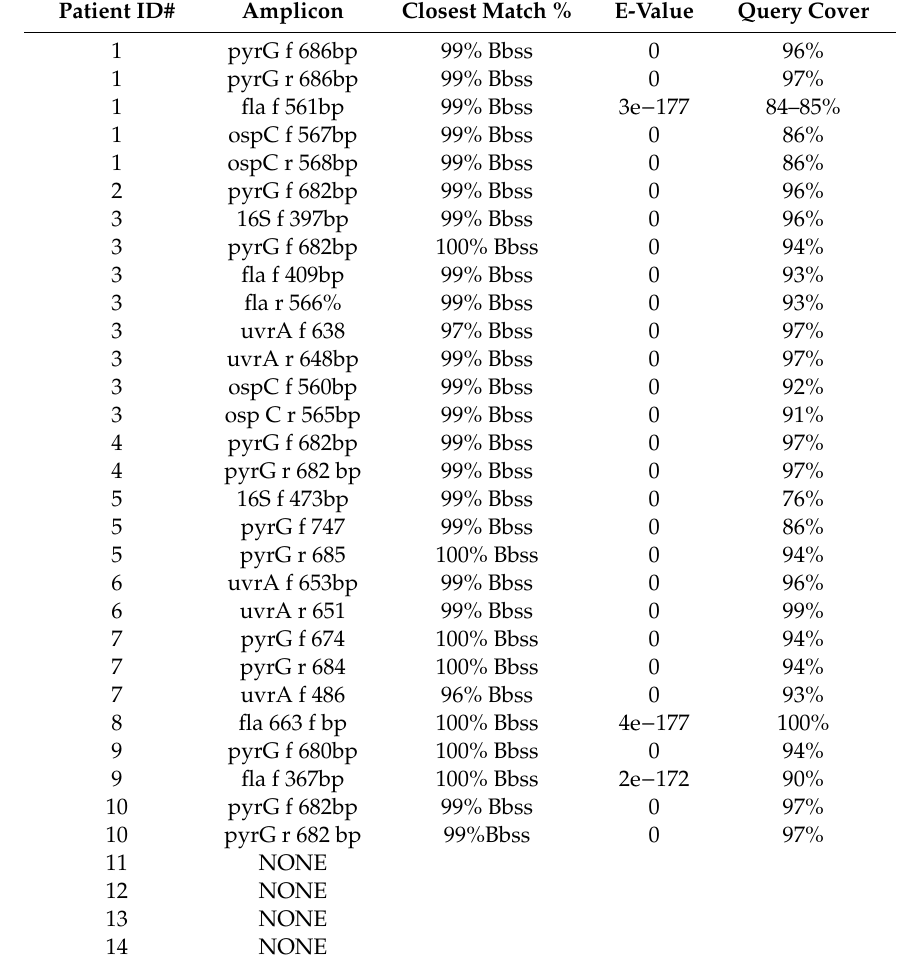
Table 5. Basic Local Alignment Search Tool (BLAST) analyses of Bb sequences.